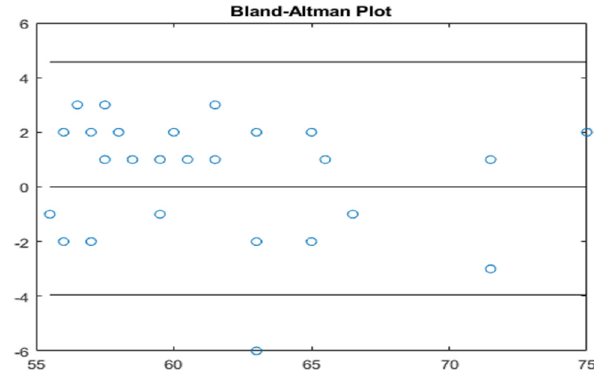
Figure 23: Bland – Altman scatter plot for the CellPer feature.